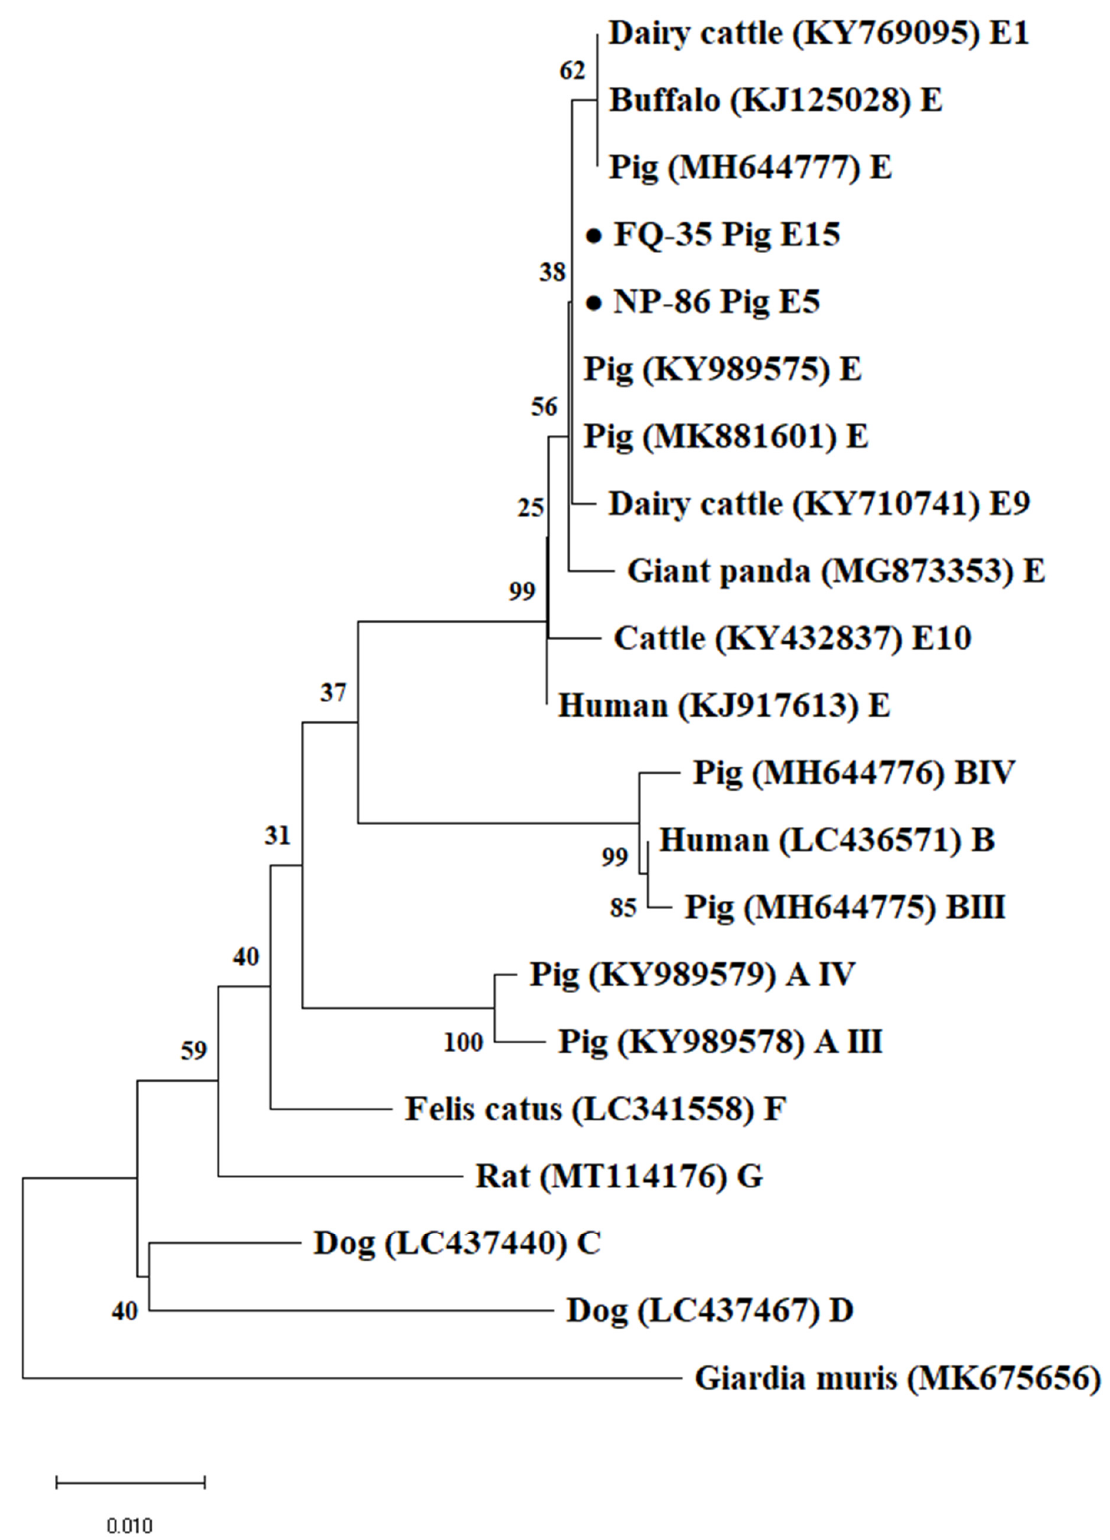
Figure 2. Phylogenetic relationships of Giardia duodenalis isolates obtained using the neighbor-joining analysis of the beta-giardin ( bg ) nucleotide sequences. Bootstrap values >50% from 1000 replicates are shown as nodes. Giardia muris was used as outgroup. Filled black circles represent bg sequences generated in this study. The scale bar indicates 0.01 nucleotide substitution/site.